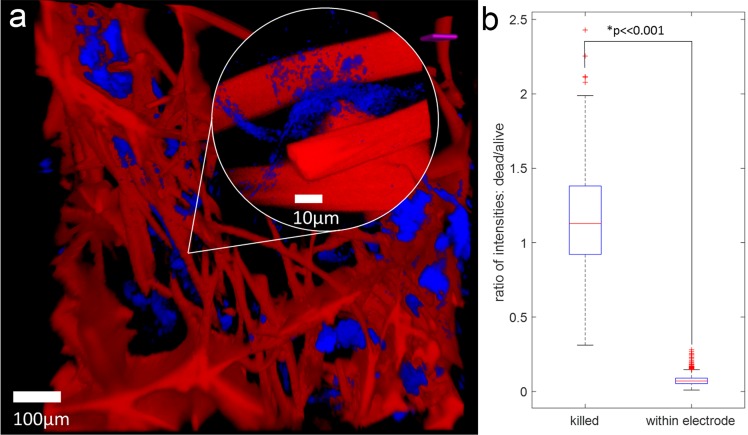
Microbial viability following m-reactor construction.(a) Fluorescent confocal microscopy image of electrodes to visualize internal interaction of bacteria (blue) with carbon felt (red). Inset shows a closeup of bacteria intertwining the conductive carbon felt, illustrating <10 μm distance between the exoelectrogens and felt. Inset is a representative image of a closeup of the bacteria, and is not a blowup of an exact region on the larger image. (b) Distribution of the ratio of intensities for control dead cells (N = 173) and samples of our reactor (N = 685). The p<<0.001 chance of similarity indicates that bacteria in the m-reactor are not dead.